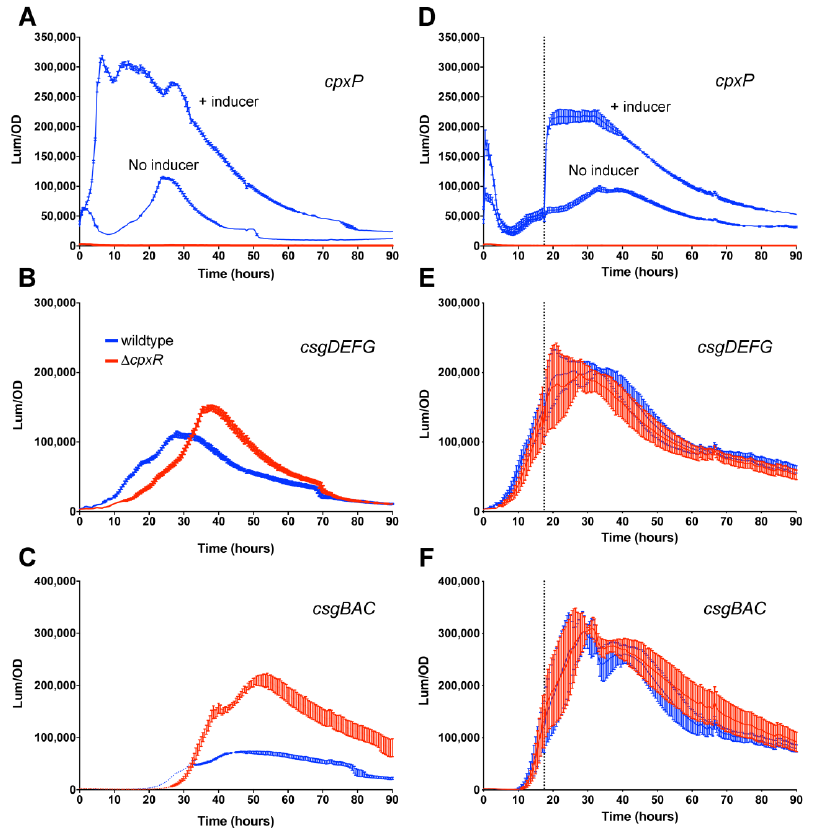
Figure 2. The Cpx system has no repressive effect on csgD transcription once the biofilm network is activated. Expression of cpxP ( A , D ), csgDEFG ( B , E ), and csgBAC ( C , F ) operons was measured during growth of S. typhimurium 14028 wild-type (blue) or ∆ cpxR strains (red) at 28 ◦ C in media supplemented with 1.0 mM CuCl 2 ( + inducer) added at the beginning of growth ( A – C ) or added after 18 h of growth ( D – F ; the vertical, dotted line represents the time of addition). For each graph, luminescence divided by the optical density at 600 nm (Lum / OD) was plotted as a function of time and each curve represents a single growth condition. The mean and standard deviations are plotted from three biological replicate experiments measured in